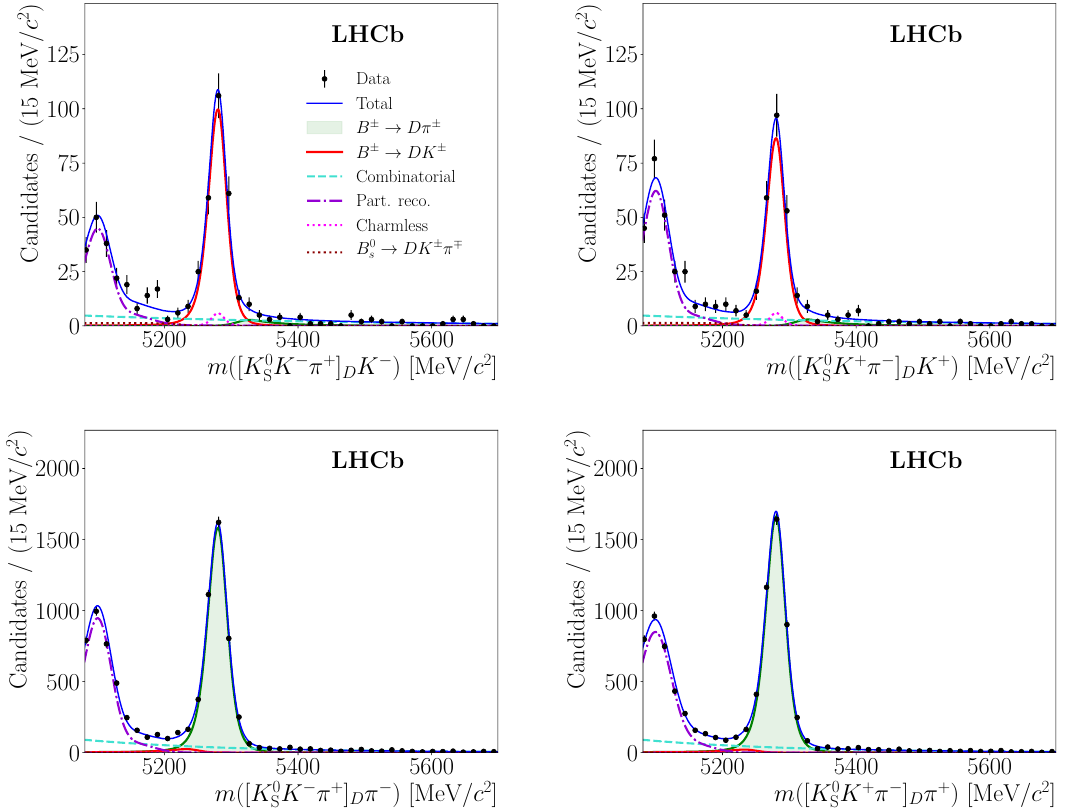
Figure 2 . Invariant mass of SS B (cid:6) dates containing both long and downstream K 0